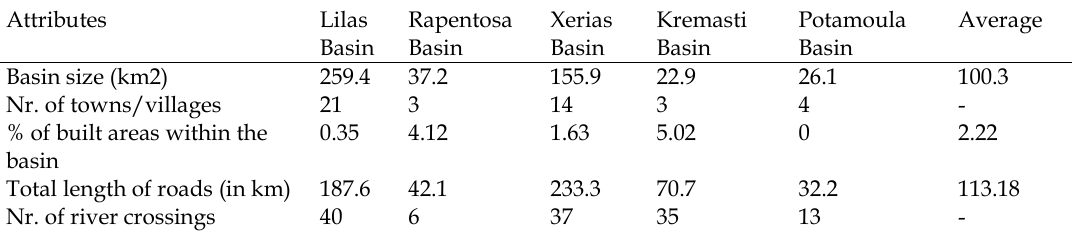
Rapentosa Xerias Basin Basin Basin